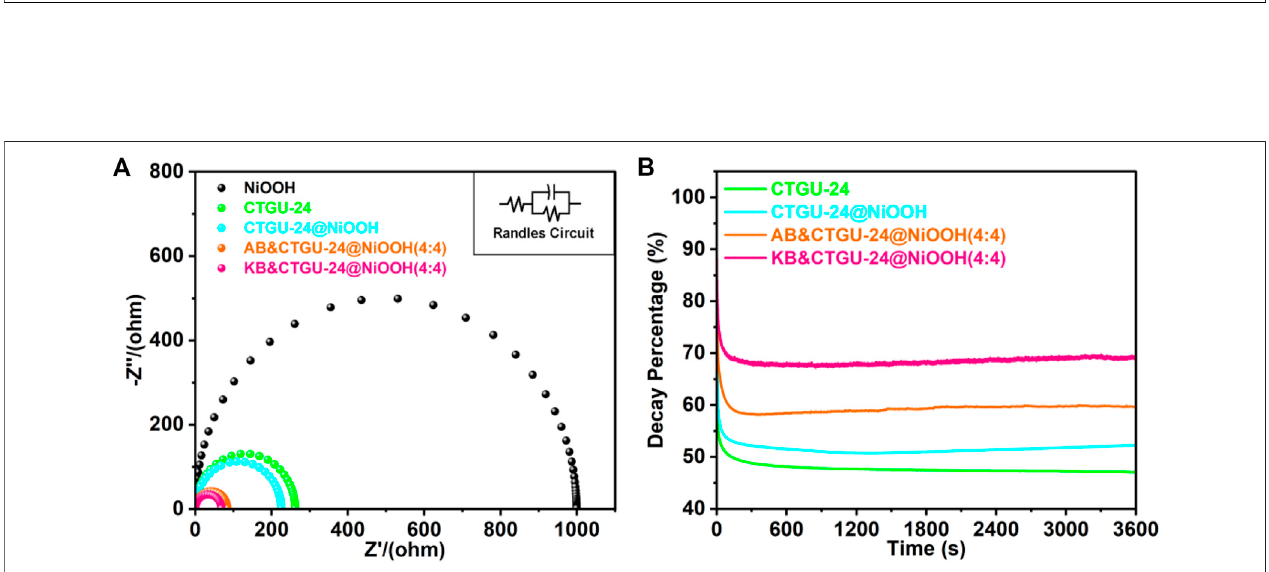
FIGURE 5 | (A) Nyquist plots of four as-synthesized catalysts. The insets is the equivalent circuit. (B) chronoamperograms for four catalysts.